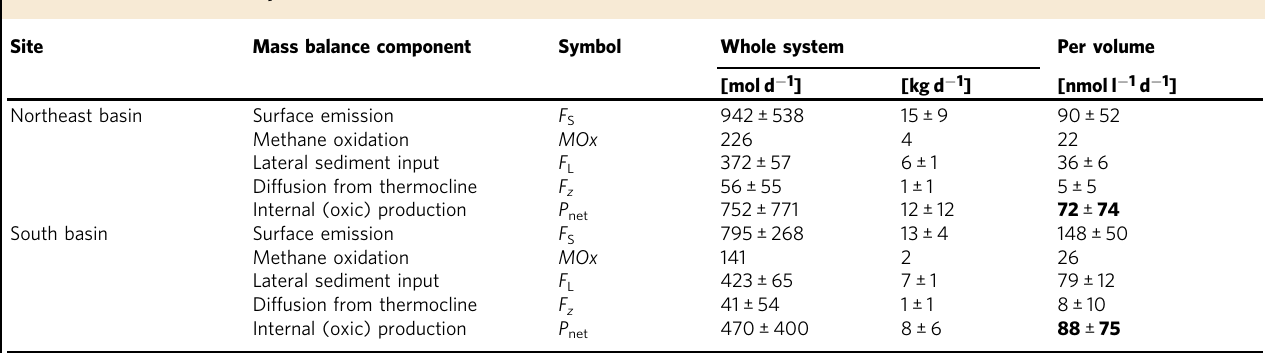
Table 1 Mass balance components.